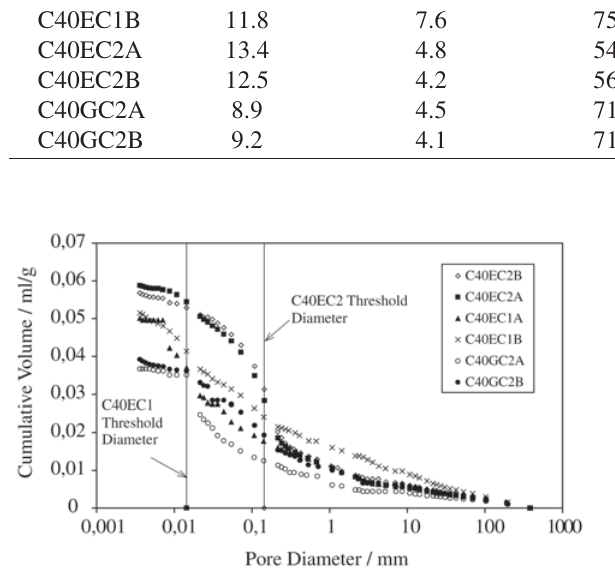
Figure 2. Mercury Intrusion Curves of Carbonated and Control